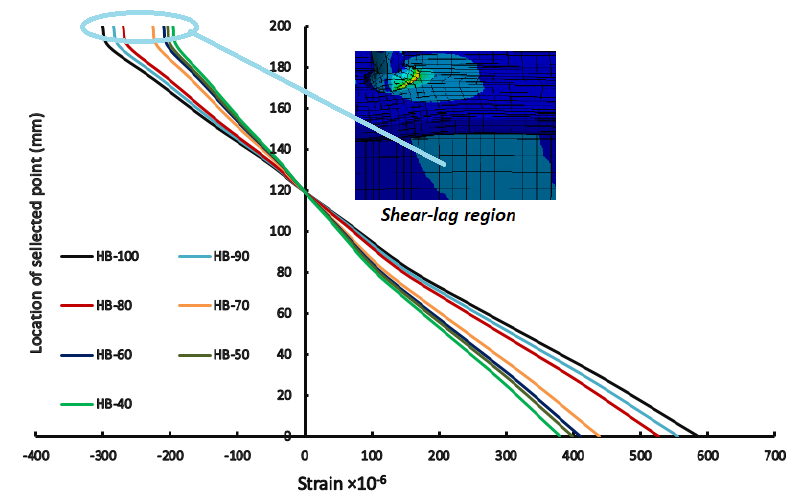
Figure 6: Strain changes at mid-span of the tested beams.